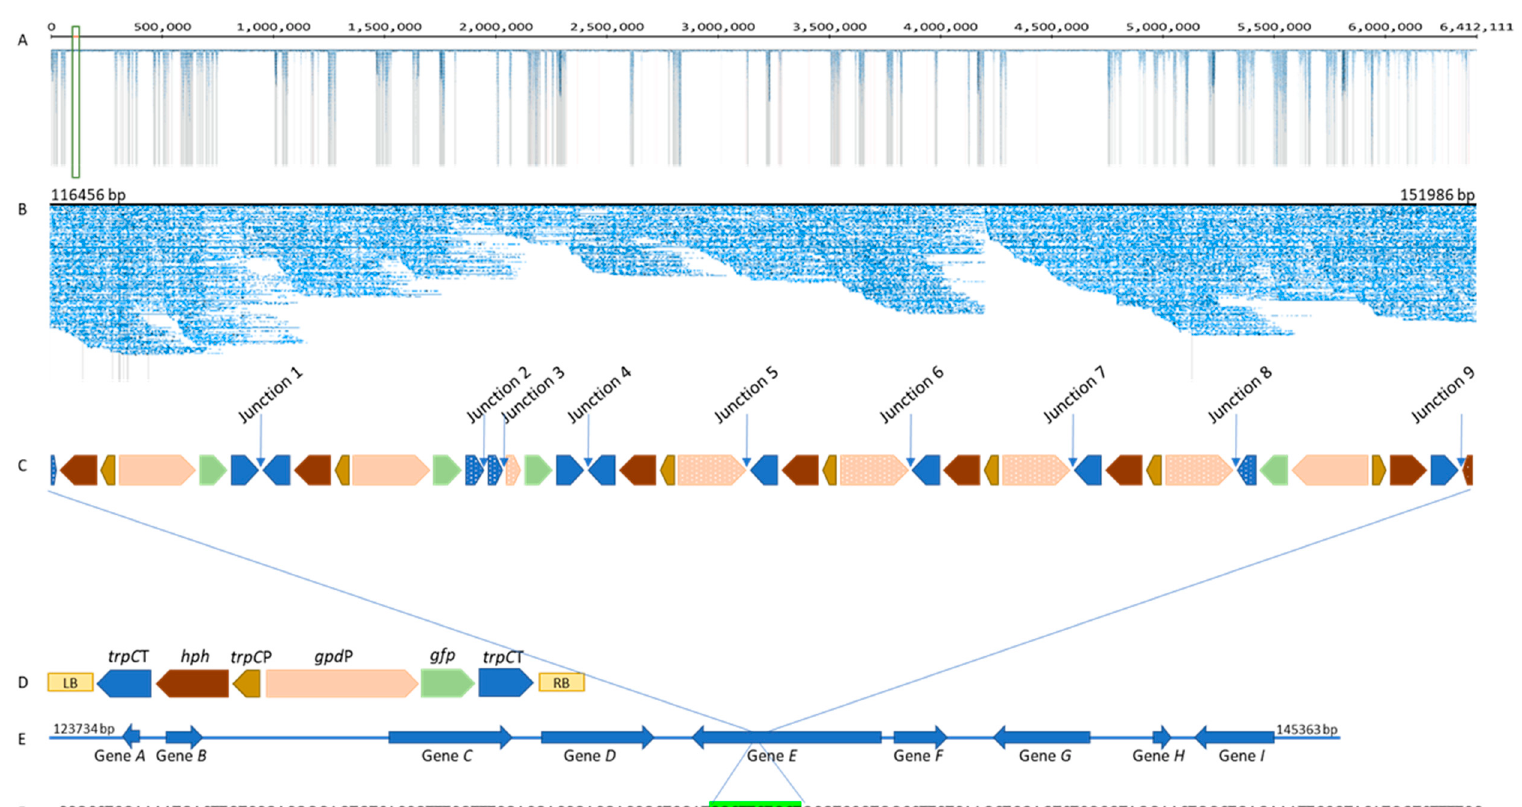
Figure 3. ( A ) Gydle output showing MinIon reads mapped to contig 3 (6,412,111 bp) of E1-GFP (integration site is highlighted in green box). ( B ) Gydle output showing MinIon reads mapped to the integration site. ( C ) Schematic representation showing the pattern of T-DNA integration in the E1 genome. Arrows indicate the junctions between T-DNAs and dotted blocks indicate truncations of more than 15 bp. ( D ) Schematic representation of the T-DNA region of the transformation vector, pEND- sgfp, showing relative position of the selectable marker ( hph ), promoter sequences ( gpd P, trpC P), reporter gene ( gfp ), terminator sequences ( trpC T), left border (LB), and right border (RB). ( E ) Schematic representation of the genes upstream and downstream of the integration site. ( F ) The 10 bp deletion in the E1 genome associated with the T-DNA event (deletion is highlighted in green).